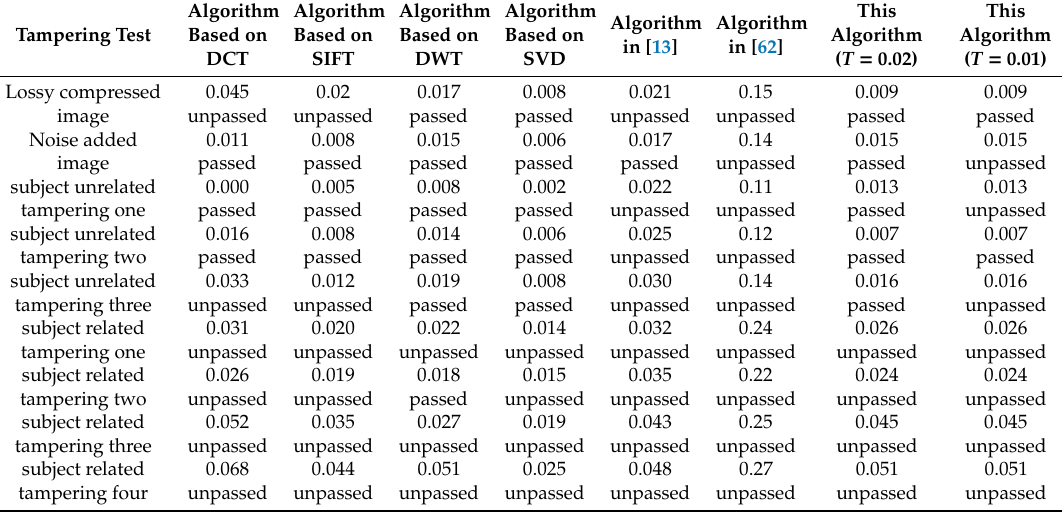
Table 1. Comparison with existing perceptual hash algorithms (normalized Hamming distance and integrity authentication result).